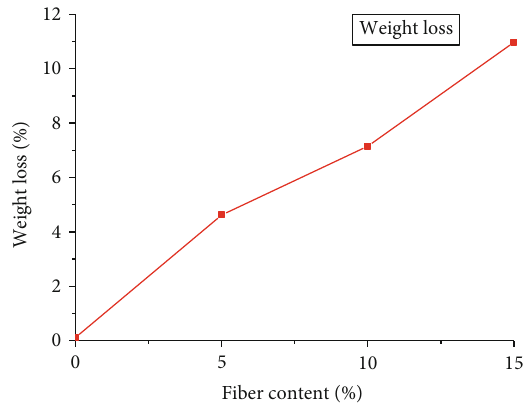
Figure 6: Percentage weight loss of the composites with di ff erent fi ber